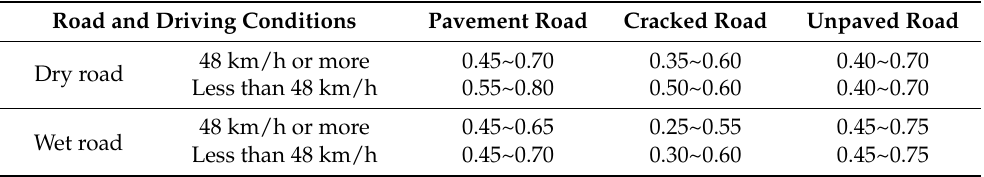
Table 3. Context-specific friction